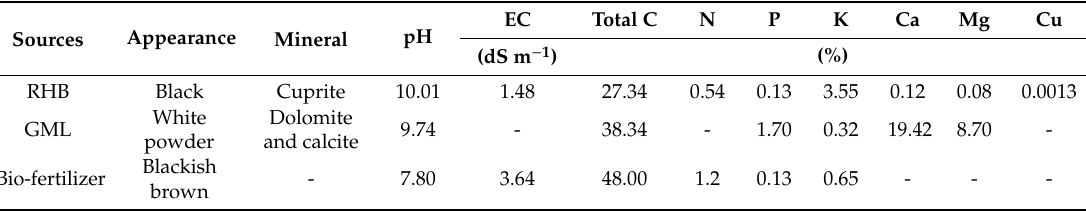
Table 3. Physico-chemical characteristics of the rice husk biochar, ground magnesium limestone and